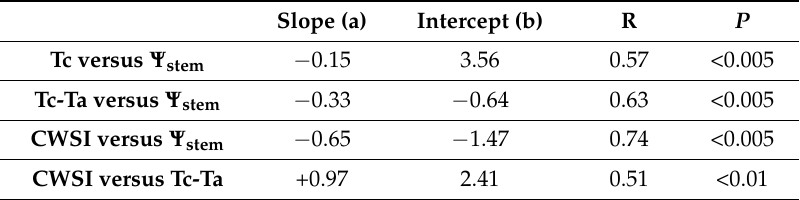
Table 4. Correlation coefficients (R) for linear regression, slope (a), and intercept (b) found between stem water potential ( Ψ stem ) versus canopy temperature (Tc), difference between canopy and air temperature (Tc-Ta), and crop water stress index (CWSI) and CWSI versus Tc-Ta of grapefruits trees, regardless of irrigation treatments, during the RDI period (from DOY 193 to 257). N = 20 (average value of each treatment and five days). Slope (a) Intercept (b) R P Tc versus Ψ stem − 0.15 3.56 0.57 <0.005 Tc-Ta versus Ψ stem − 0.33 − 0.64 0.63 <0.005 CWSI versus Ψ stem − 0.65 − 1.47